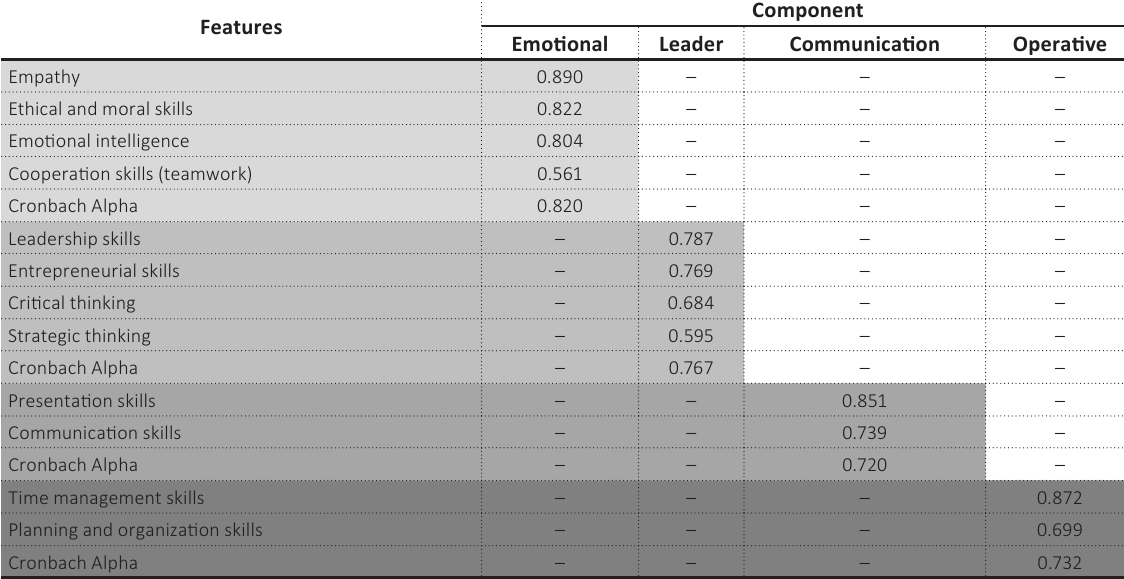
Table 6. Soft skill compliance